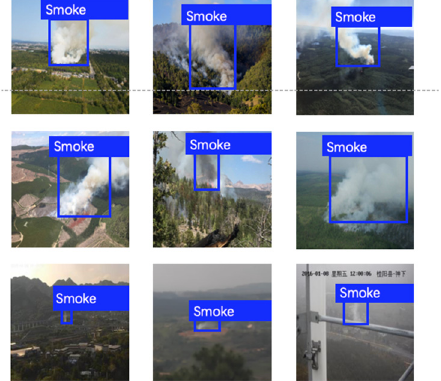
Figure 7. Recognition effect of the proposed